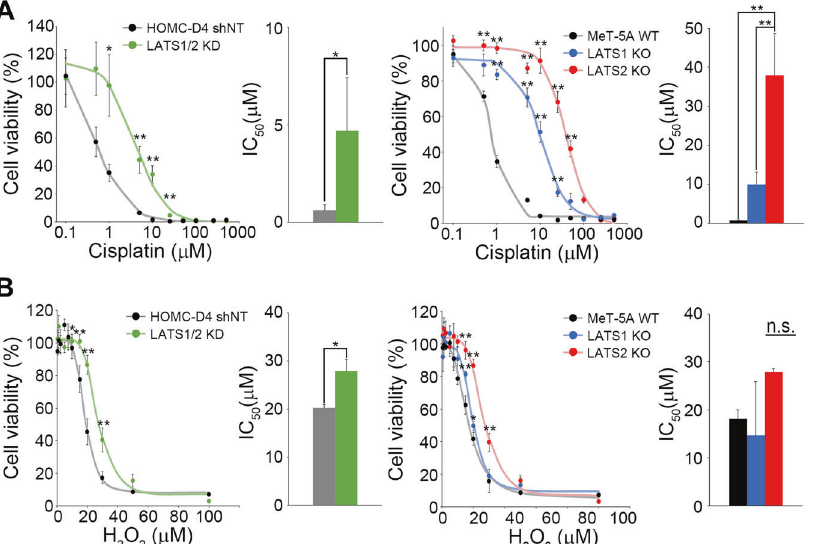
Fig. 1 LATS2-inactive cells showed cisplatin resistance. Effect of cisplatin ( A ) and H 2 O 2 ( B ) on LATS1/2 KD HOMC-D4 and LATS1 or LATS2 KO MeT-5A cells. The cells were treated with various concentrations of cisplatin or hydroperoxide for 24 h. After the medium change, the cells were cultured for an additional 48 h, and then cell viability was measured using CCK-8. All experiments were performed at least three independent times. Data are presented as means ± SD, and p values were calculated using the Tukey-Kramer method. * indicates p < 0.05 and ** indicates p < 0.01. n.s. means no signi fi cant